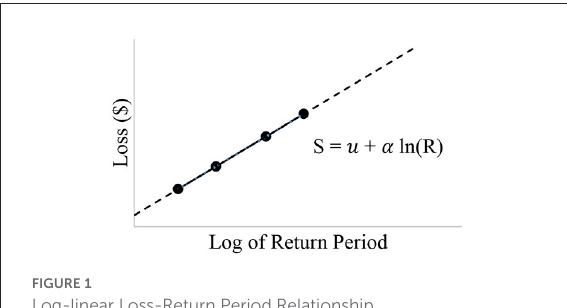
FIGURE1 Log-linear Loss-Return Period